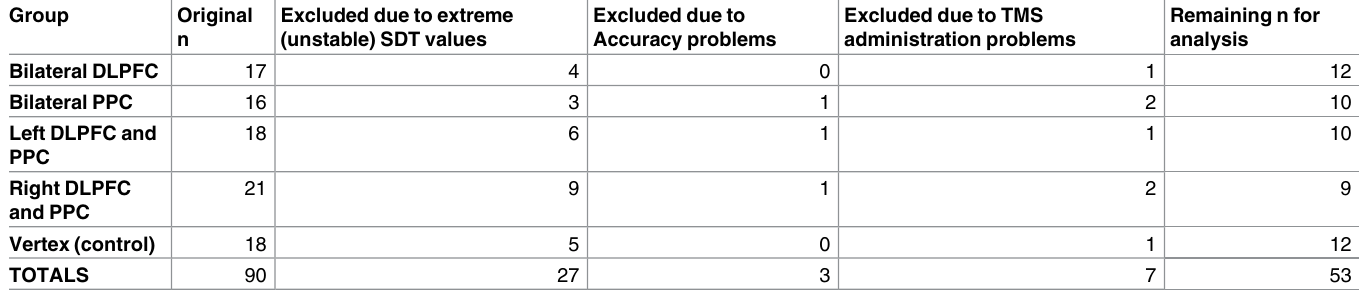
Table 1. List of inclusions and exclusions for experiment 1